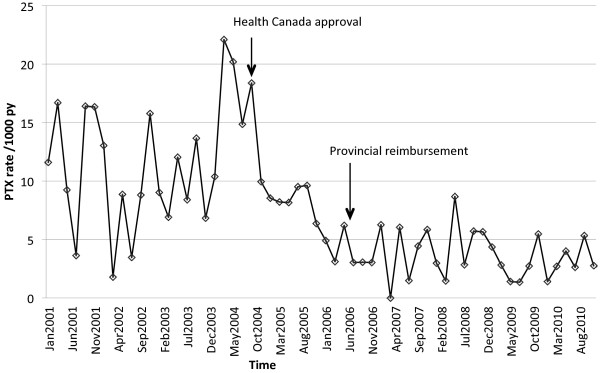
Bimonthly parathyroidectomy rates. Abbreviations: PTX, parathyroidectomy; py, person-year.